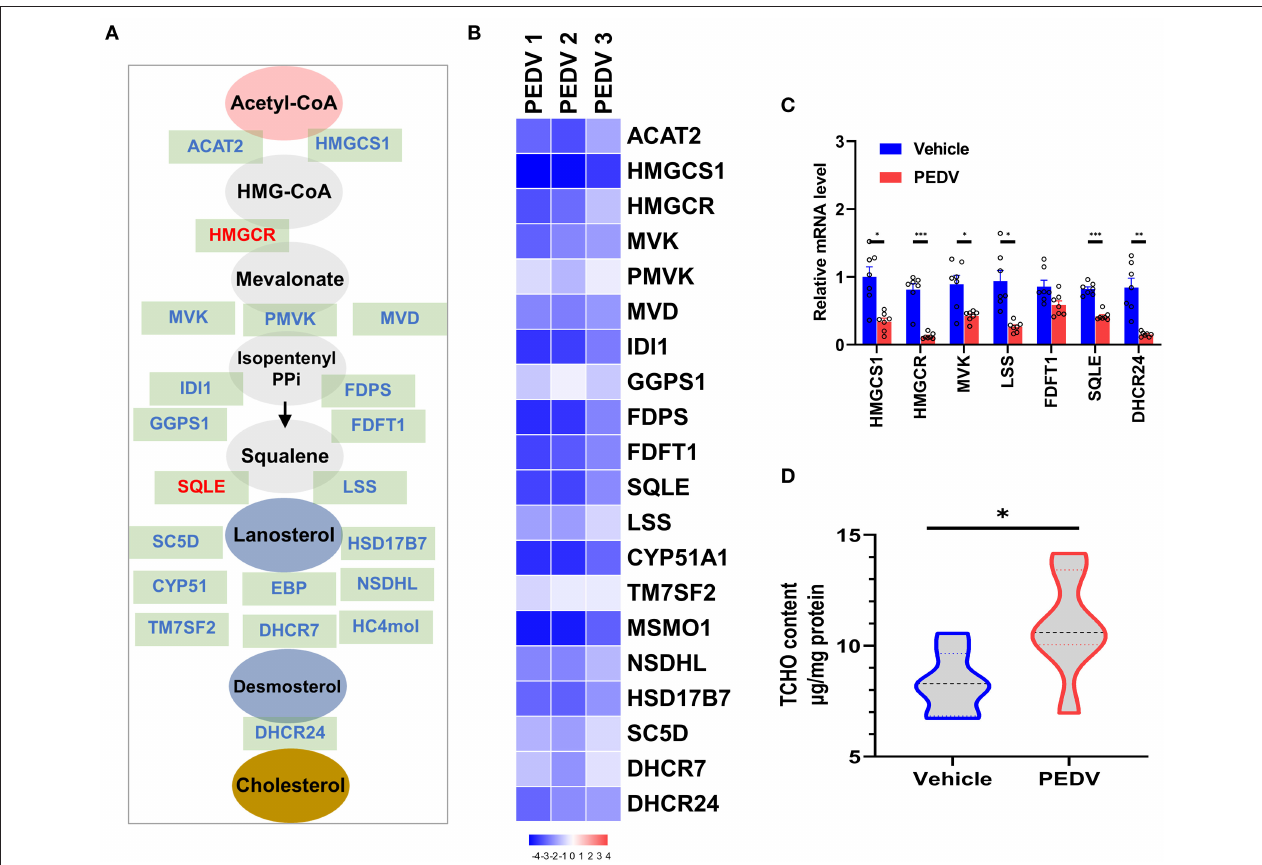
FIGURE 2 | The expression of genes in the cholesterol biosynthesis pathway and cholesterol content in piglet livers. (A) The graphic scheme of the cholesterol biosynthesis pathway from acetyl-CoA. The core genes involved in cholesterol biosynthesis were highlighted in blue, while two rate-limiting enzymes 3-hydroxy-3-methylglutaryl-CoA reductase (HMGCR) and SQLE were highlighted in red. (B) Heatmap of messenger RNA (mRNA) expression (RNA-seq) changes of the cholesterol biosynthesis genes in the livers of PEDV-infected piglets (log2 transformed, normalized to Control). (C) The qRT-PCR analysis confirmed changes of the cholesterol biosynthesis genes in the livers of PEDV-infected piglets. (D) Total cellular cholesterol contents in the livers of the control and PEDV-infected piglets were analyzed and normalized to total protein concentrations. The data are shown as the means ± SEM, * P < 0.05, ** P < 0.01, *** P < 0.001, using the two-tailed Student t